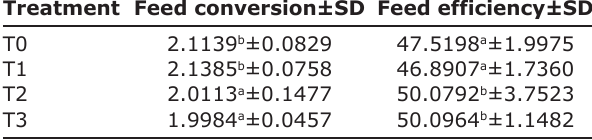
Table-2: Feed conversion and feed efficiency of quail in 4 weeks of treatment.